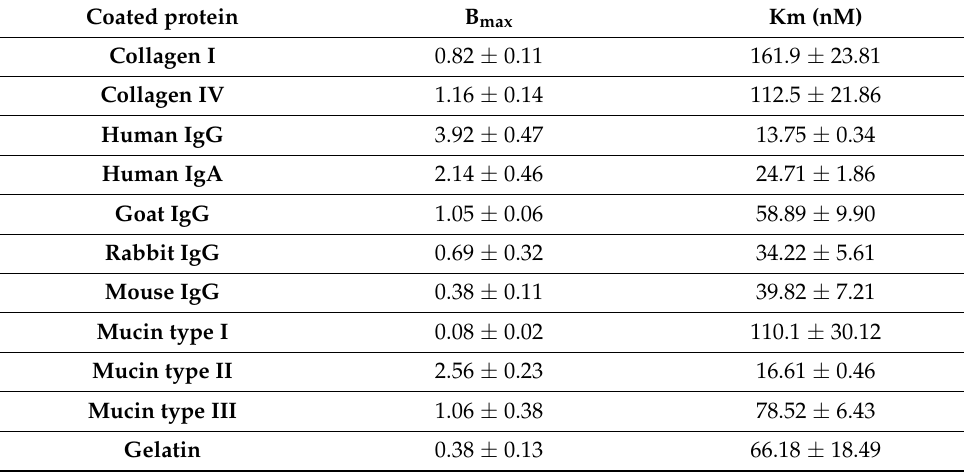
Having shown that the RadA Ig-like domain interacts at the same time with collagens, immunoglobulins and mucins, the role of the carbohydrate motifs exhibited by these proteins and recognized by GST-RadA 35-252 was evaluated using collagen IV, human IgG and mucin type II as model proteins. Collagen IV, human IgG and mucin type II were chemically deglycosylated for 30 min (i.e., DG 30 min) or 3 h (i.e., DG 3 h), and their interaction with GST-RadA 35-252 was then evaluated. Efficient deglycosylation of each substrate was confirmed using a solid-phase binding assay with the lectin wheat-germ agglutinin (Figure 5A).